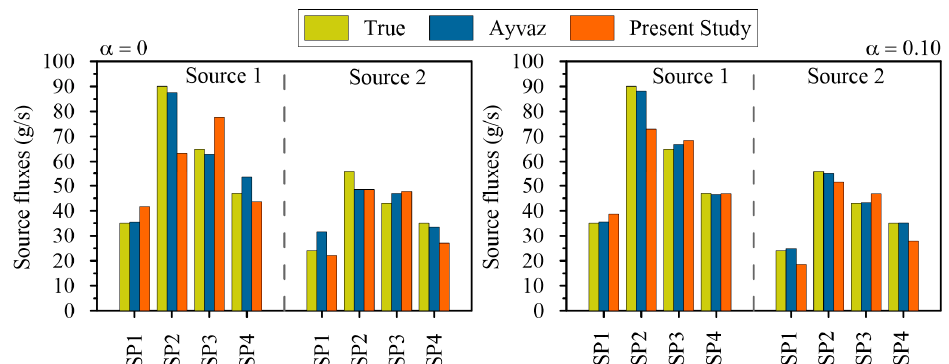
Figure 6. Recovered release histories of sources 1 and 2 in error-free data condition ( α = 0) and in error-perturbed data condition ( α = 0.1).